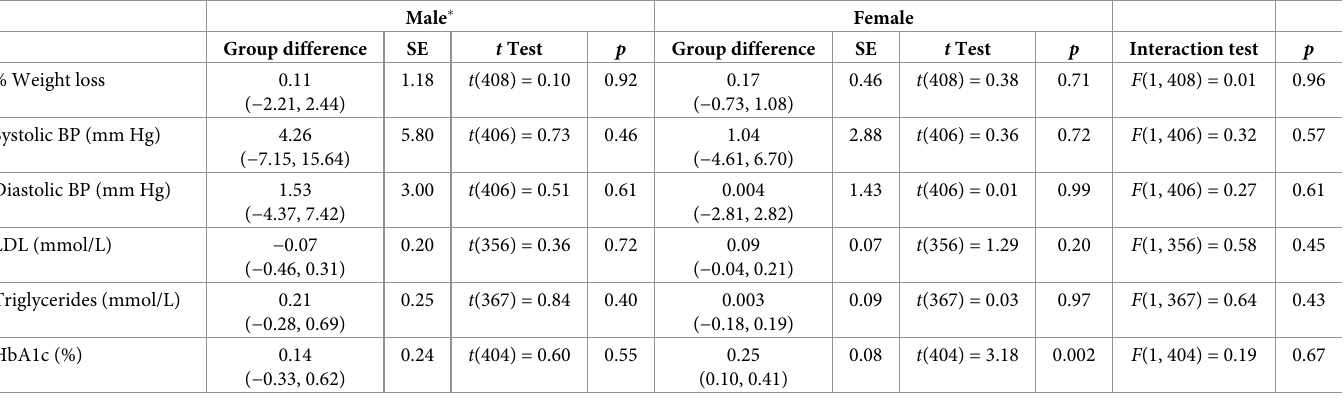
into normal ( < 5.7%), prediabetic (5.7% to 6.4%), and diabetic ( > 6.4%) categories and deter- mined if improvements or deteriorations in diabetes category differed by group. In the control arm, 8% (4/49) of participants improved from the diabetes category and 13% (16/119) improved from the prediabetes category. In the Lifestyle Africa arm, 14% (9/65) of participants improved in the diabetes category, and 26% (24/93) improved in the prediabetes category. In